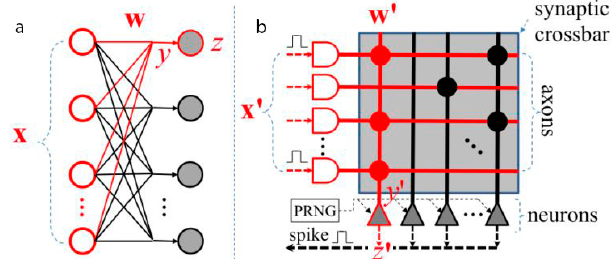
Figure 9. Mapping a Deep Artificial Neural Network (DANN) ( a ) to a neuromorphic chip like the TrueNorth ( b ). The input neurons are represented with the red and white shapes (x and x’), and the output neurons with the grey shapes (z and z’). The weights (w) to the neuron z are approximated using a Pseudo Random Number Generator (PRNG), resulting in the weights (w’) to the neuron z’ in the neuromorphic chip [74].